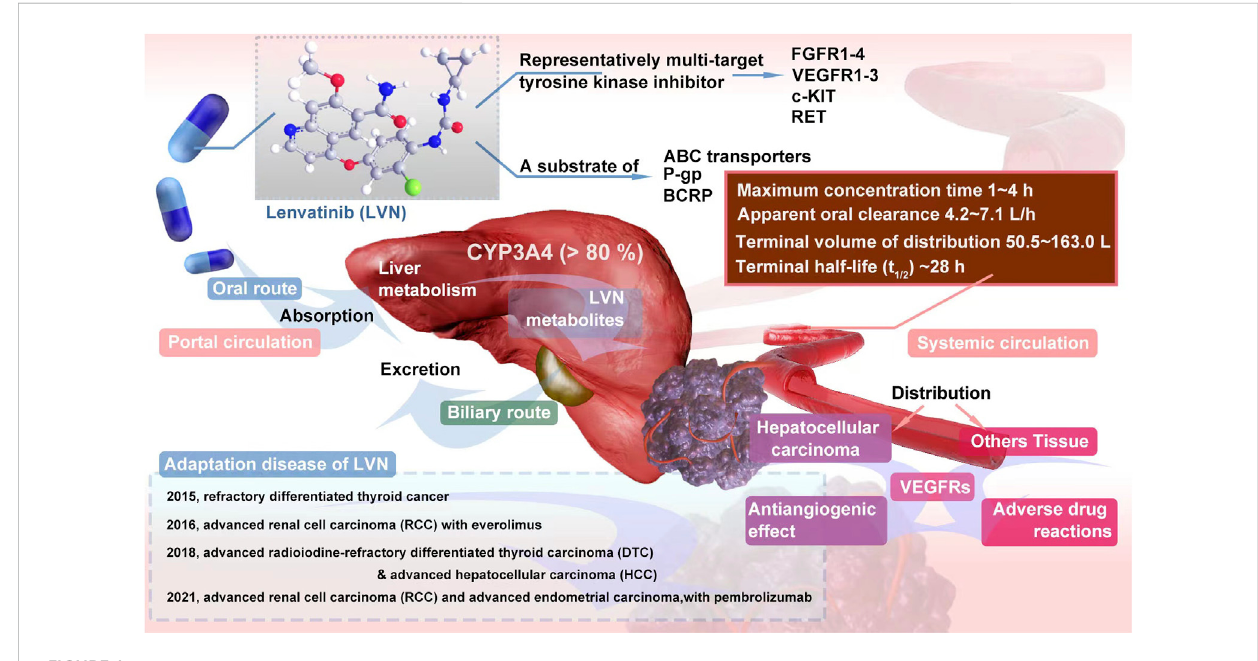
FIGURE 1 Overview of LVN pharmacodynamics and pharmacokinetics in vivo and the time line of Indication approval.